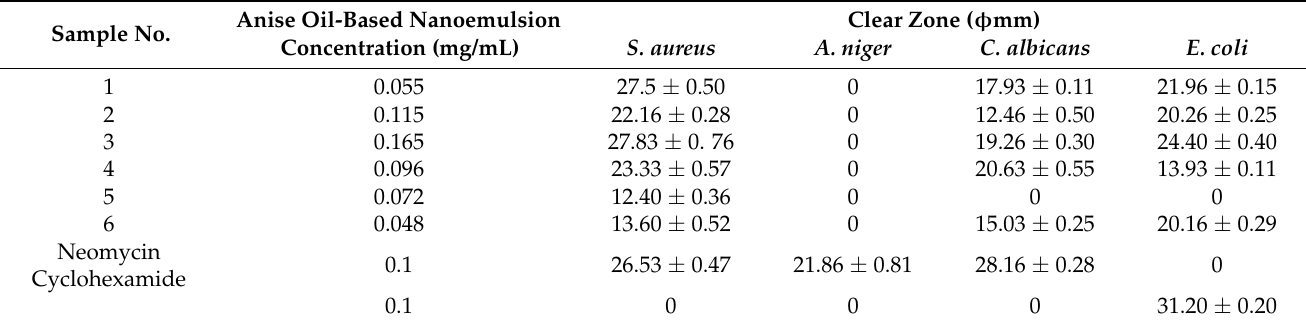
Table 2. The antimicrobial activities of different concentrations of anise oil-based nanoemulsion against different test microbes. Sample